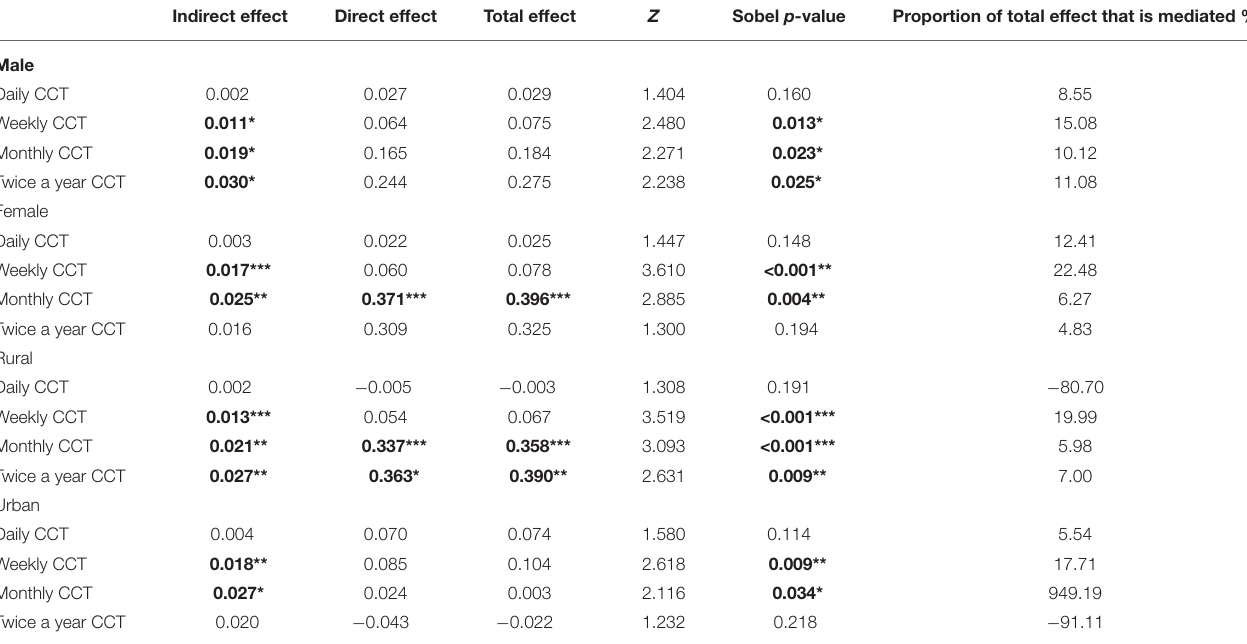
TABLE 4 | Gender and residence subgroup analysis of the mediation model of healthy aging vs. 45 and older parent satisfaction-mediated child